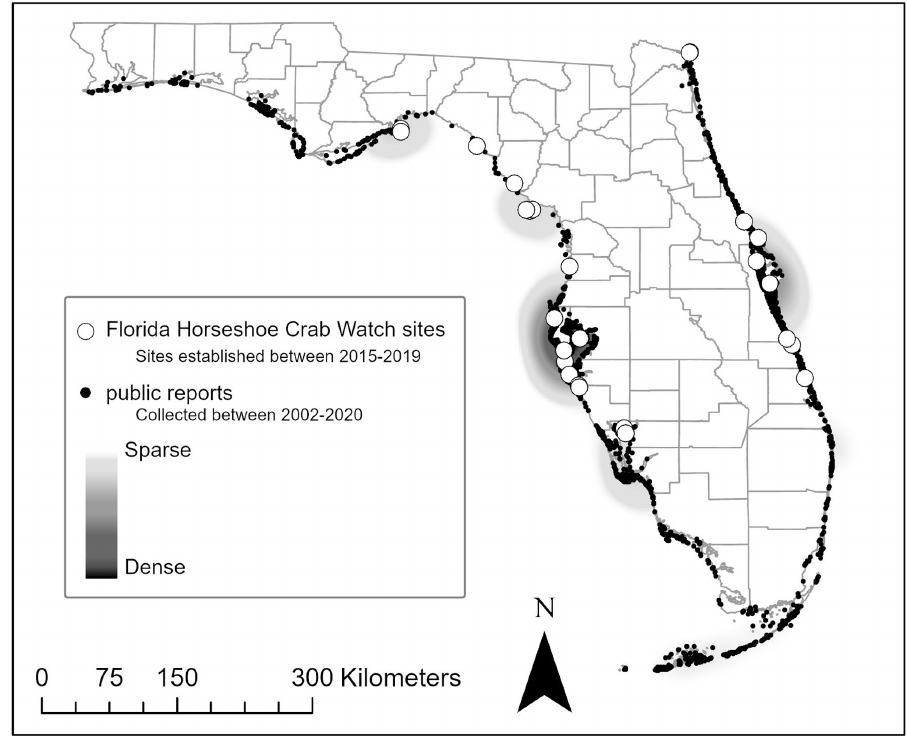
Figure 2 Florida Horseshoe Crab Watch sites (open circles) and public reports (closed circles). Shading shows relative density of public reports.